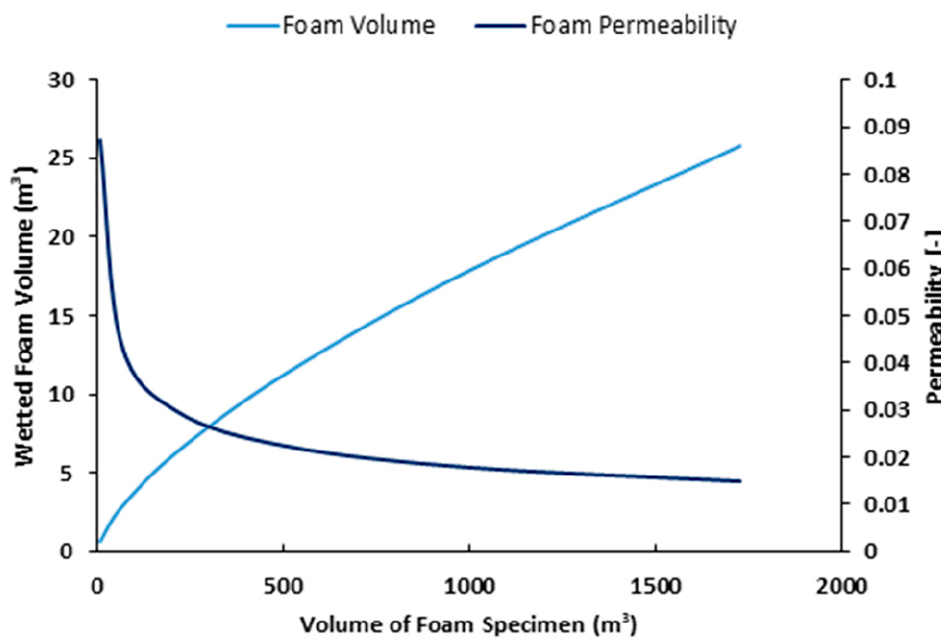
Figure 7. Effect of specimen size on permeability determination.